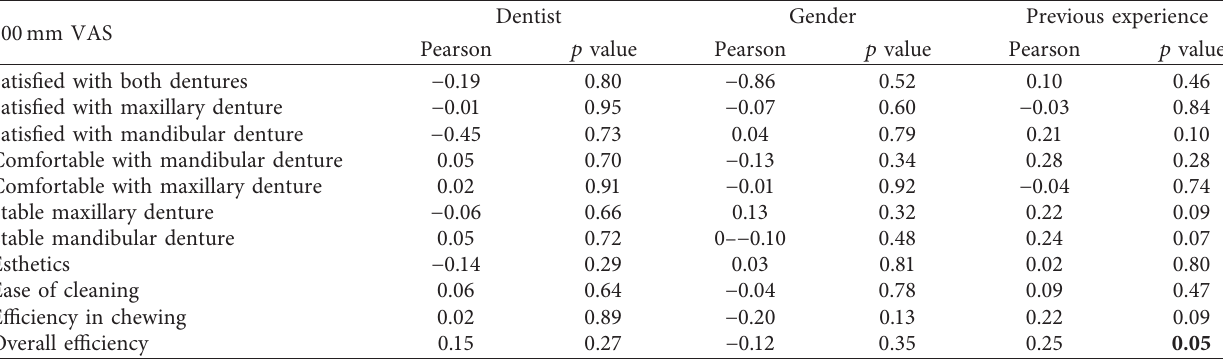
Table 1: Results of Pearson correlations along with p value measured at a significant level of p < 0 . 05 for dentist, gender, and previous experience versus all variables of the 100mm VAS scale part of the questionnaire.